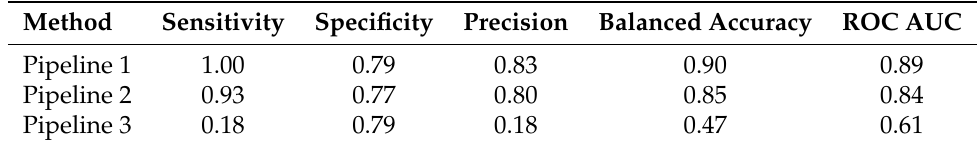
Table 1. Evaluation metrics obtained by applying Pipelines 1, 2, and 3 to the radiomic dataset. For each pipeline, the sensitivity, specificity, precision, balanced accuracy, and ROC AUC scores obtained on the test sets are reported.